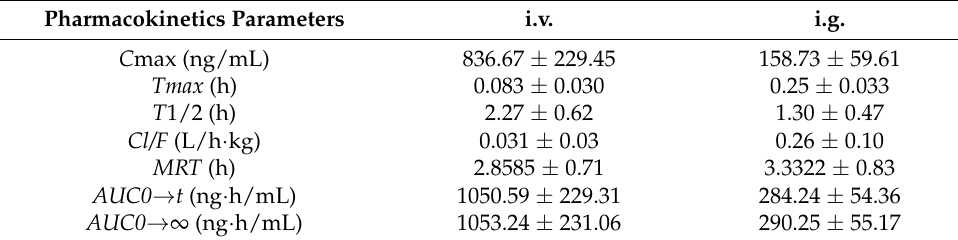
Figure 4. Mean plasma concentration-time profile after a single intravenous administration of 10 mg/kg 3c solution to rats ( A ) and after a single oral dose of 40 mg/kg 3c solution ( B ) ( n = 6, mean ± SE). Table 3. The non-compartmental model pharmacokinetic parameters in rats after a single intravenous injection (10 mg/kg) and intragastric administration (40 mg/kg) of compound 3c . ( n = 6; Mean ± SD). Pharmacokinetics Parameters